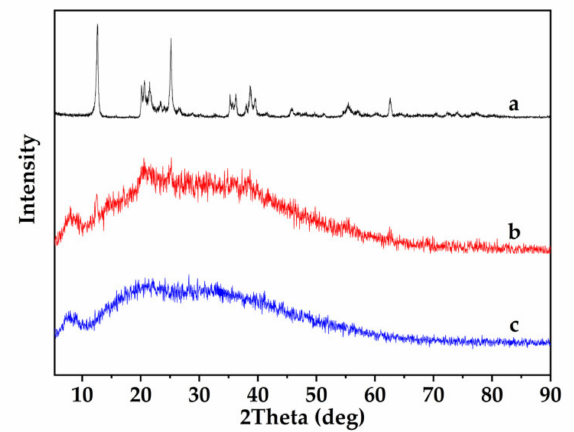
Figure 3. X-ray diffraction XRD patterns of ( a ) KL, ( b ) SAPC (4 wt. % KL) and ( c )